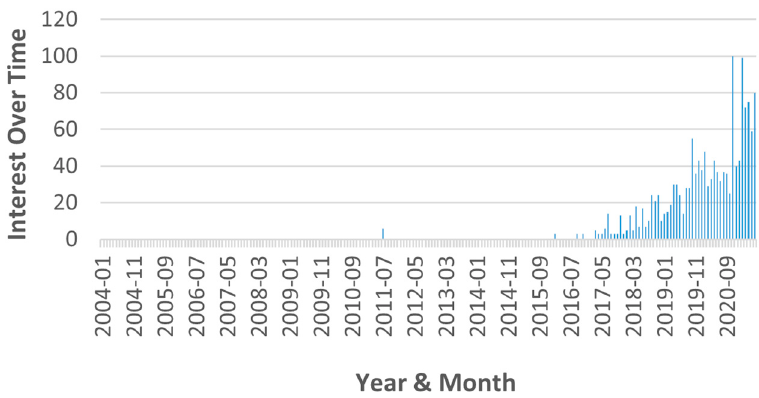
Figure 1. Interest shown for the term “explainable AI” in Google